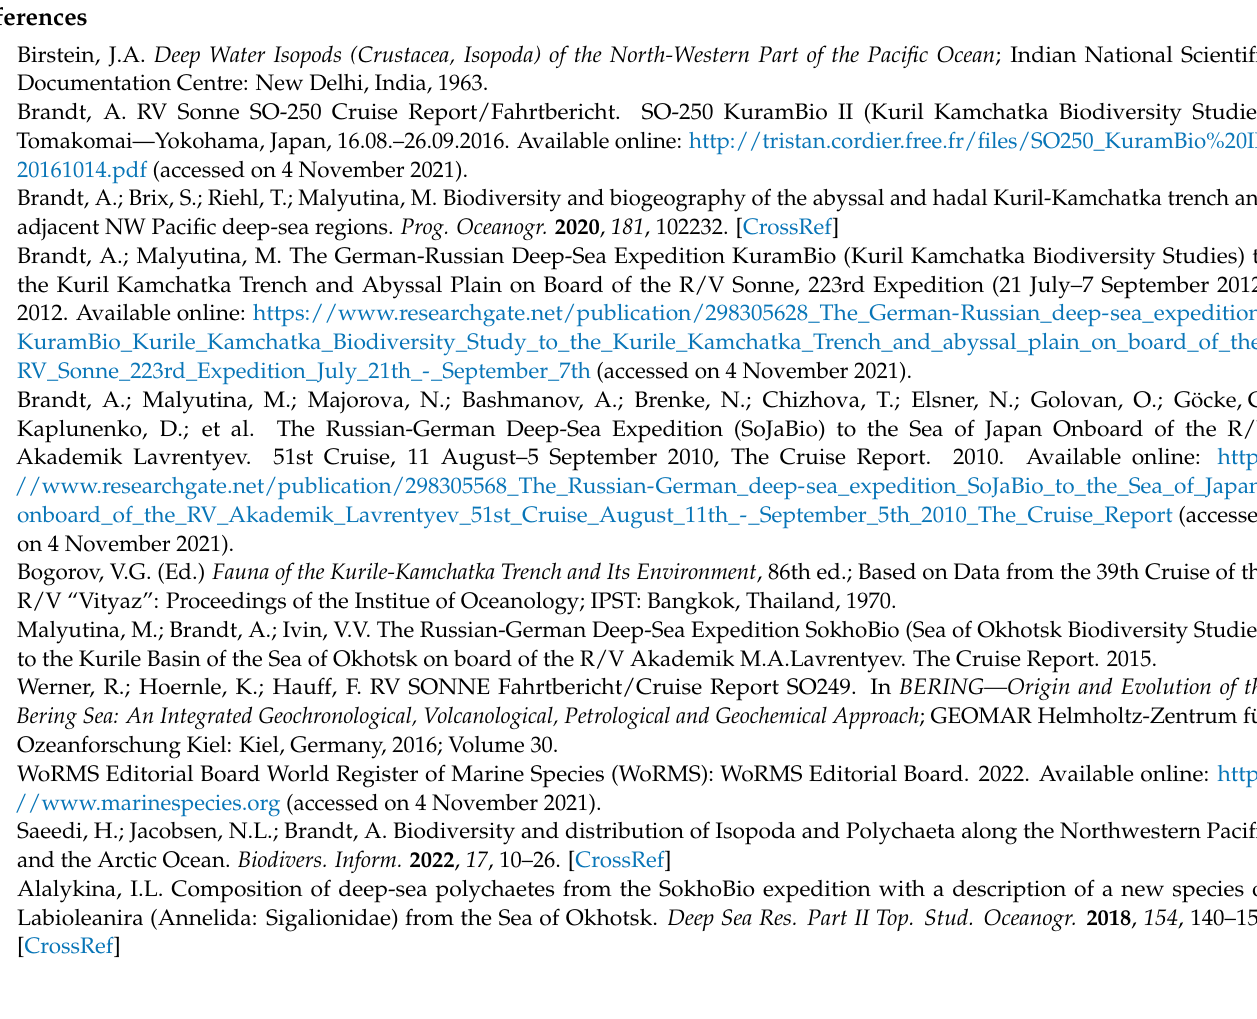
representing the latitudinal distribution of polychaete records for each order across the Northwest Pacific; Figure S8: Violin plot representing the latitudinal distribution of sipunculan records for each order across the Northwest Pacific; Table S1: Citations of the OBIS